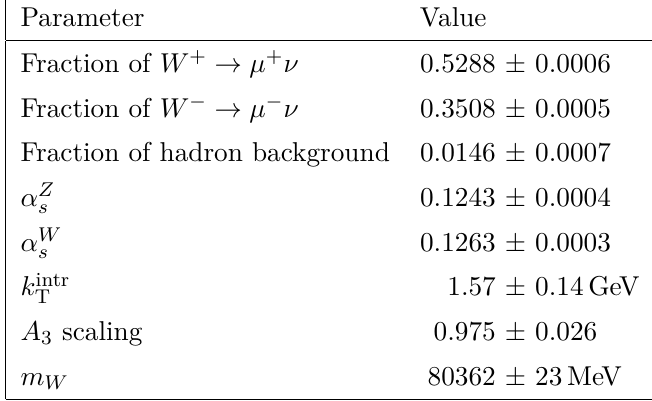
Table 4 . Values of the parameters determined in the m W fit with the NNPDF31_nlo_as_0118 PDF set. The uncertainties quoted are